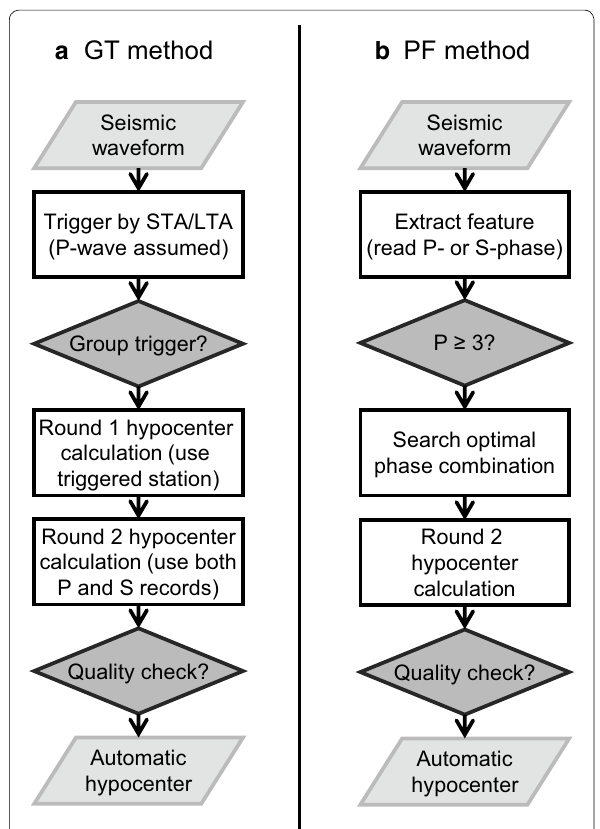
Fig. 2 Flowchart of automatic hypocenter estimation processes: a GT method and b PF method